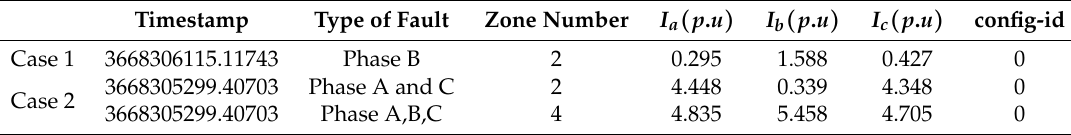
Figure 8. Experimental setup showing the GPS module to measure timestamp. Table 3. Information stored in database when simulation with real GPS module was carried